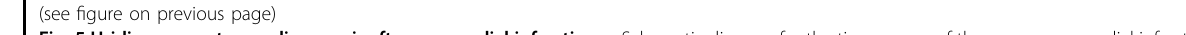
Fig. 5 Uridine promotes cardiac repair after myocardial infarction. a Schematic diagram for the time course of the mouse myocardial infraction (MI) modeling and vehicle or uridine treatment. Uridine or vehicle treatment were performed every other day, as indicated by the red arrows. b Left, representative echocardiographic images of sham mice ( n = 6 mice) and mice treated with vehicle ( n = 13 mice) or uridine ( n = 13 mice) at day 7 after MI modeling and intramyocardial injection of vehicle or uridine. Right, quantitative data of left ventricular ejection fraction (LVEF) and left ventricular fractional shortening (LVFS). Data are presented as the means ± SEM (two-tailed unpaired Student ’ s t- test). c Quantitative analysis of LDH and CK level of sham mice ( n = 15 mice) and mice treated with vehicle ( n = 25 mice) or uridine ( n = 25 mice) on the next day after MI modeling and intramyocardial injection of vehicle or uridine. Data are presented as the means ± SEM (two-tailed unpaired Student ’ s t- test). d Gene set enrichment analysis showing relative expression levels for downregulated DEGs upon myocardial infarction (top) and upregulated DEGs upon myocardial infarction (bottom) in the heart tissues from vehicle- or uridine-treated mice. e Top, Venn diagram showing the downregulated genes upon myocardial infarction and upregulated genes upon uridine treatment as compared to vehicle treatment. The overlapped genes were de fi ned as “ rescue DEGs (upregulated) ” (left). Ring-heatmap plot showing the relative expression levels of “ rescue DEGs (upregulated) ” in mouse myocardial infarction model (right). Bottom, Venn diagram showing the upregulated genes upon myocardial infarction and downregulated genes upon uridine treatment as compared to vehicle treatment. The overlapped genes were de fi ned as “ rescue DEGs (downregulated) ” (left). Ring-heatmap plot showing the relative expression levels of “ rescue DEGs (downregulated) ” in mouse myocardial infarction model (right). The color key from blue to amaranth indicates log 2 (fold change) values from low to high. f Top, GO term and pathway enrichment analysis of “ rescue DEGs (upregulated) ” in mouse myocardial infarction model. Bottom, GO term and pathway enrichment analysis of “ rescue DEGs (downregulated) ” in mouse myocardial infarction model. The color keys from white to red or blue indicate – log 10 ( P -value) from low to